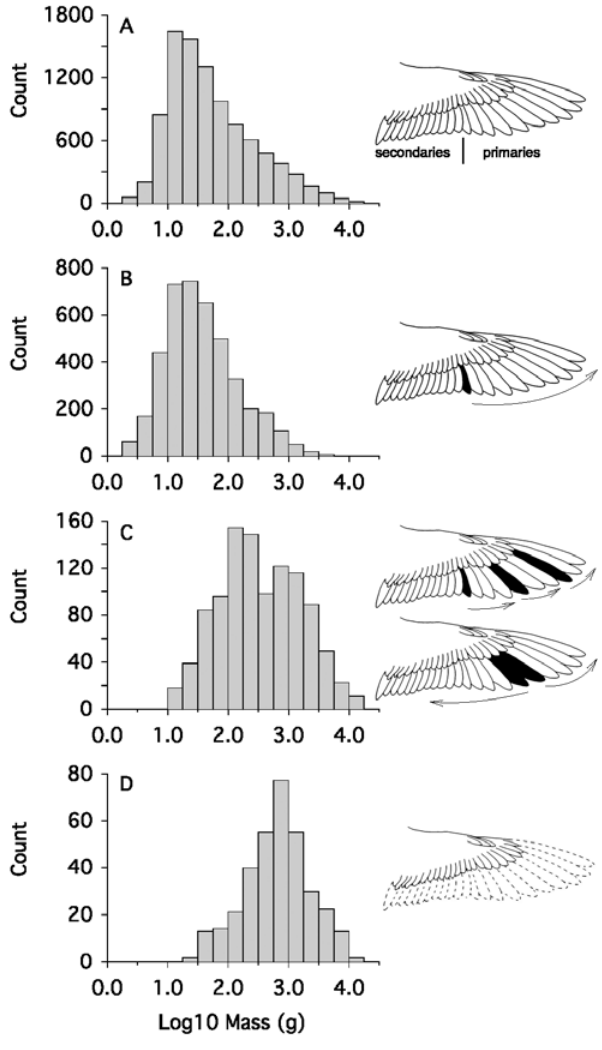
Figure 2. Body size distributions associated with different patterns of primary replacement; dark feathers are points of molt initiation. (A) Size distribution for all flying birds (wing shows primary and secondary flight feathers). (B) Size distribution for species with simple molts, characterized by a single wave of primary replacement. (C) Size distribution for species with complex molts that feature either (1) multiple waves of primary replacement proceeding distally through the primaries, or (2) division of the primaries into two molt series with feathers replaced in opposite directions. (D) Size distribution for species that replace their primaries (and secondaries) simultaneously (wing shows lost primaries and secondaries depicted by dotted lines). Most species with simple molts (B) fail to approach 15 kg, the approximate upper size limit of birds set by the power available for flight because such large birds would require too much time to replace their flight feathers. But species with complex (C) and, especially, simultaneous primary replacement (D) reach the upper size limit of birds set by the power required for flight because these modes of primary replacement require less time than simple